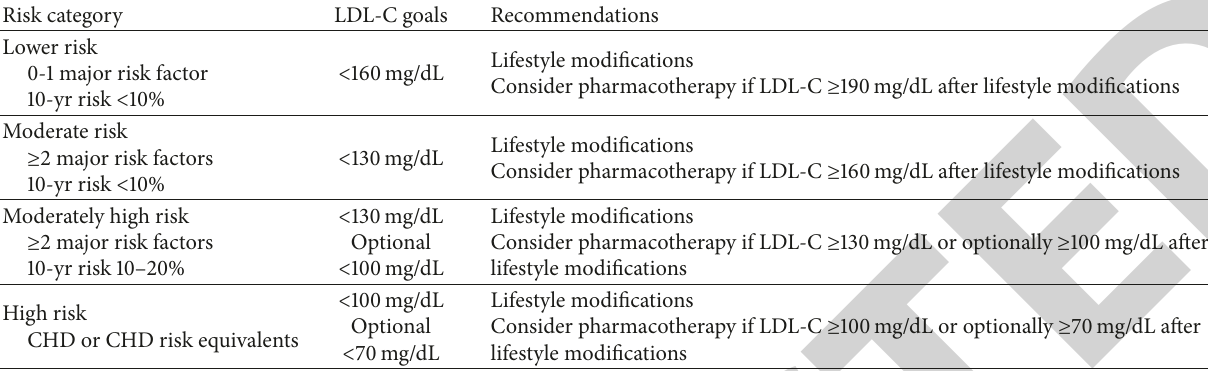
Table 5: Goals for lowering LDL-C